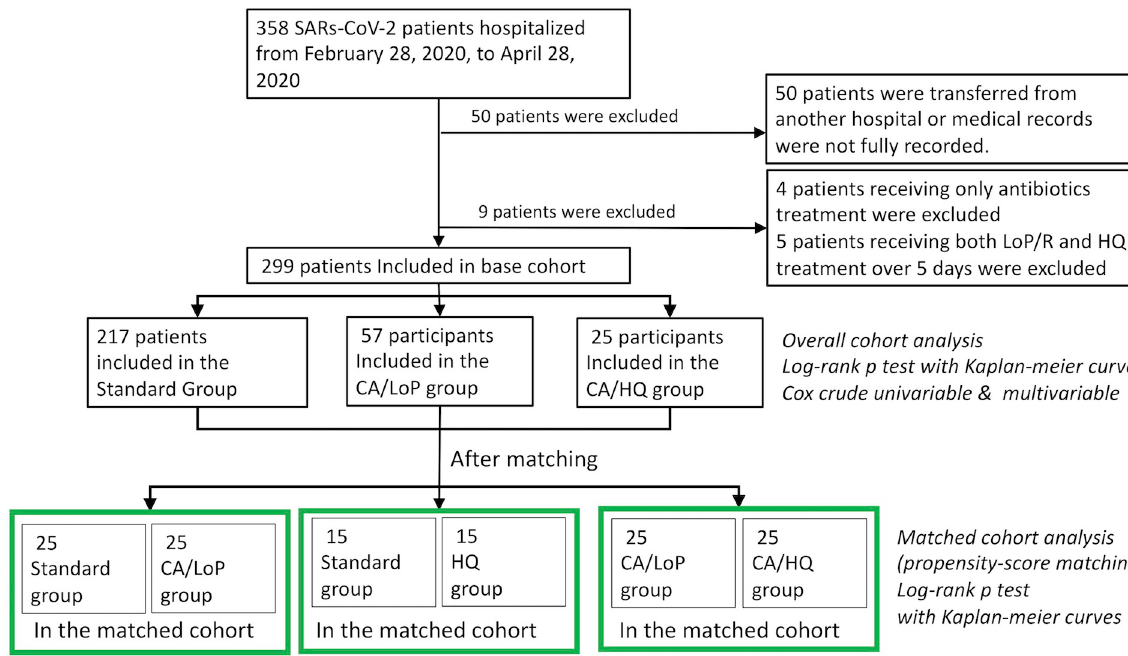
Fig 1. Flowchart of the study. Abbreviations: LoP/R, Lopinavir/Ritonavir; HQ, Hydroxychloroquine; CA/LoP, Cephalosporin, Azithromycin, Lopinavir/Ritonavir; CA/HQ, cephalosporin, Azithromycin, Hydroxychloroquine. https://doi.org/10.1371/journal.pone.0267645.g001 PLOS ONE | https://doi.org/10.1371/journal.pone.0267645 May 4,